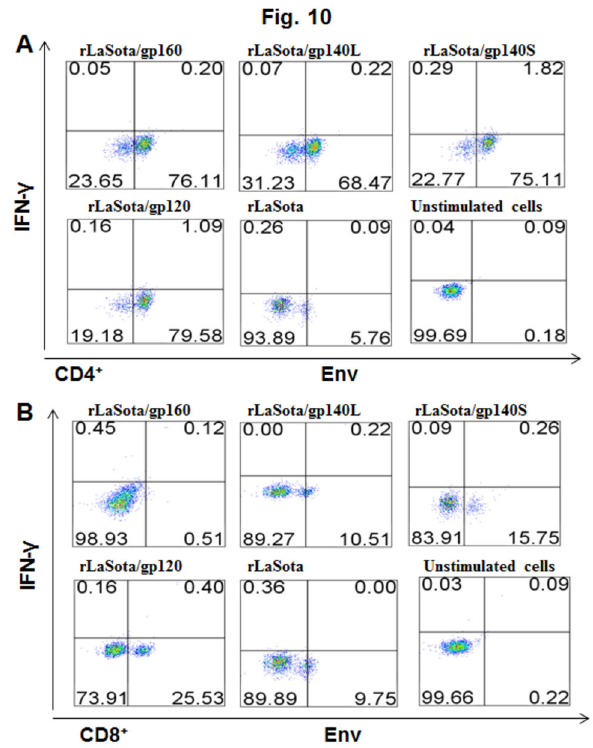
Figure 10. HIV-1 Env-specific CD4+ (panel A) and CD8+ (panel B) T cell response. Mice in groups of 6